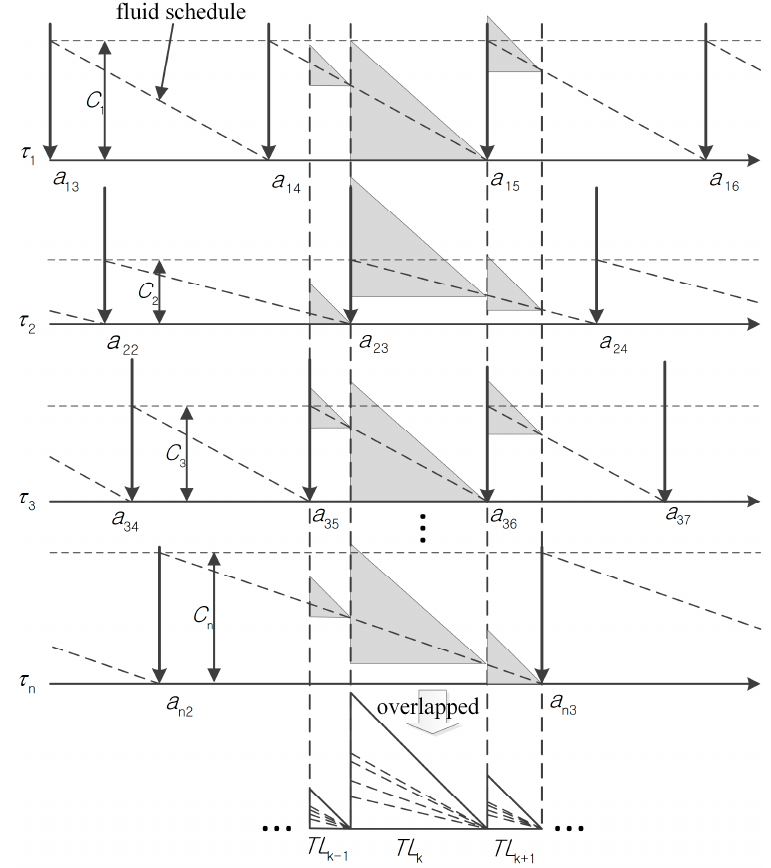
Figure 2. Example of T-L plane construction.